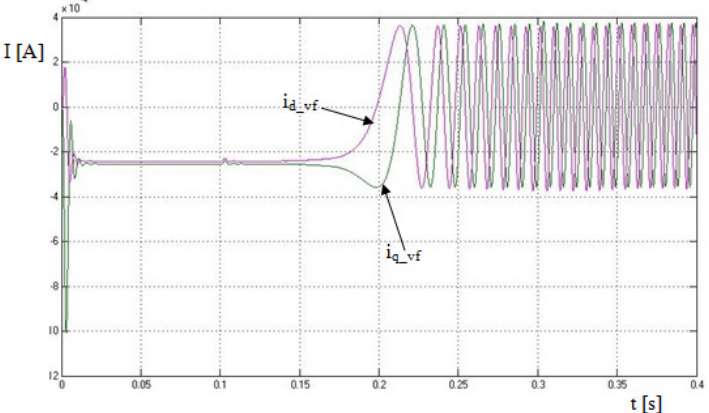
Figure 11. The course of position signals in dq when NSDR is introduced .